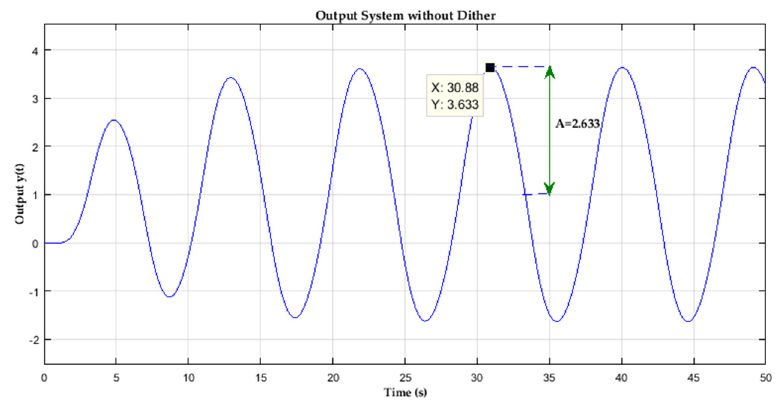
Figure 5. Simulink block diagram of the relay control system with dither injection.